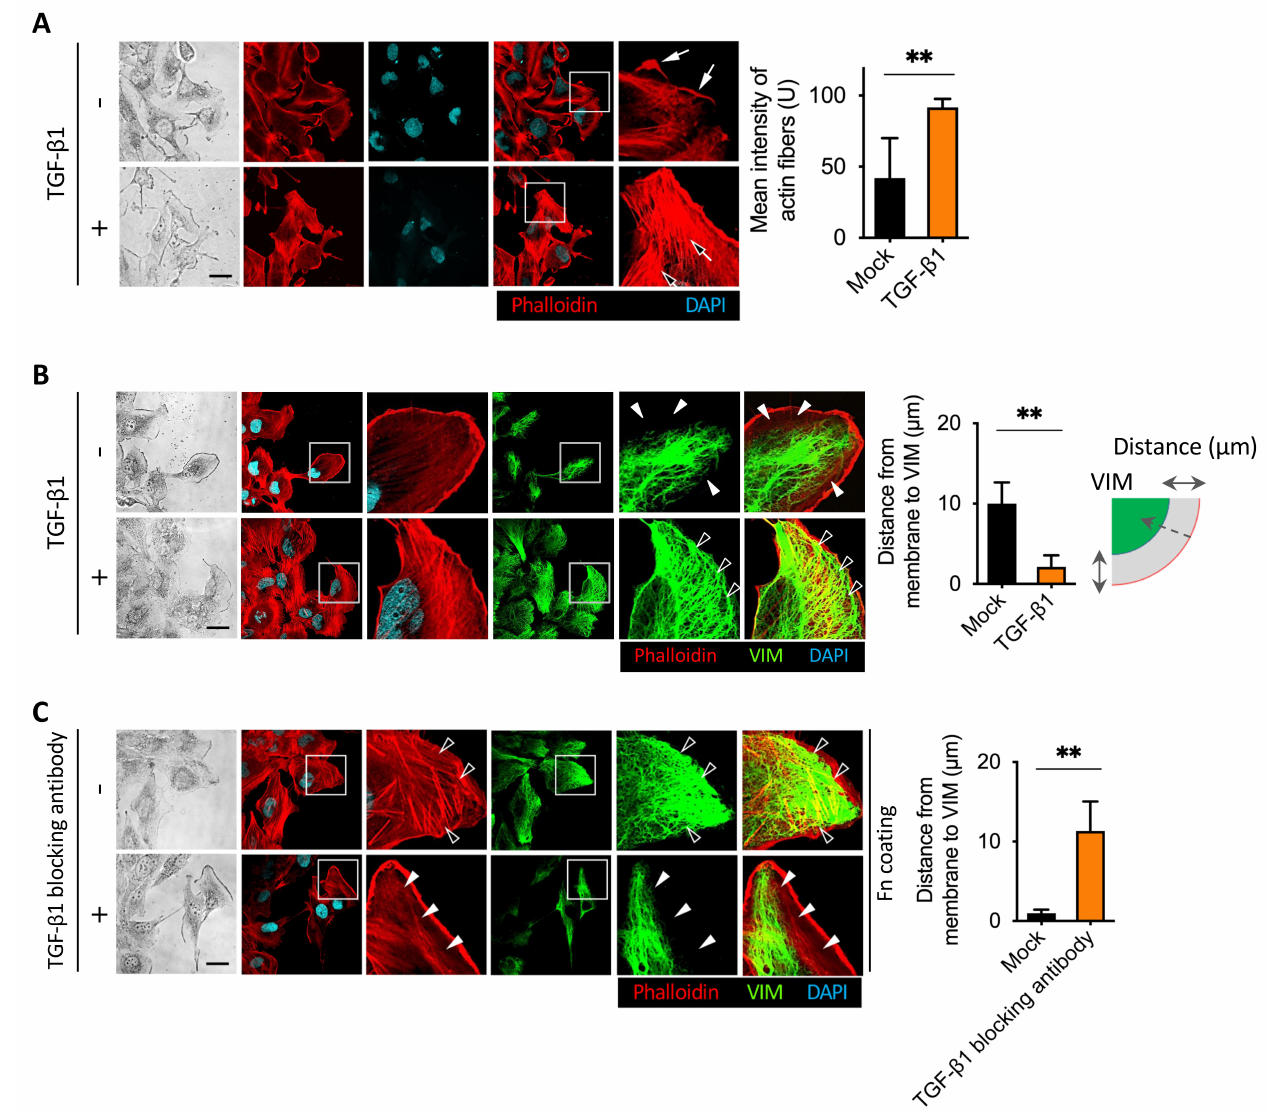
Figure 3. TGF- β 1 induced vimentin intermediate filament networks and actin stress fibers formation. ( A ) Representative immunofluorescence assay of TGF- β 1-induced actin stress fibers formation in the leading cells. BFTC909 cells were seeded in a wound healing chamber overnight, and the migration was performed for 24 h, followed by treatment with or without TGF- β 1 ligands for another 24 h. The cells were then fixed and stained with phalloidin, and the intensity of the stress fibers was quantified and plotted. Black arrow: actin stress fibers. White arrow: lamellipodia. Scale bars: 10 µ m. ** p < 0.01. Data are means ± s.d. (two-tailed t -test) from experiments with three replicates ( n = 8 fields for each experiment). ( B ) Representative images showing that TGF- β 1 promoted vimentin intermediate filament networks and actin stress fibers formation in BFTC909 cells. ** p < 0.01. Data are means ± s.d. (two-tailed t -test) from experiments with three replicates ( n = 8 fields for each experiment). ( C ) Representative images showing that TGF- β 1-blocking antibody reduced vimentin intermediate filament networks and actin stress fibers formation in BFTC909 cells. Arrowheads: the space between the intracellular membrane and vimentin. Scale bars: 10 µ m. ** p < 0.01. Data are means ± s.d. (two-tailed t -test) from experiments with three replicates ( n = 8 fields for each